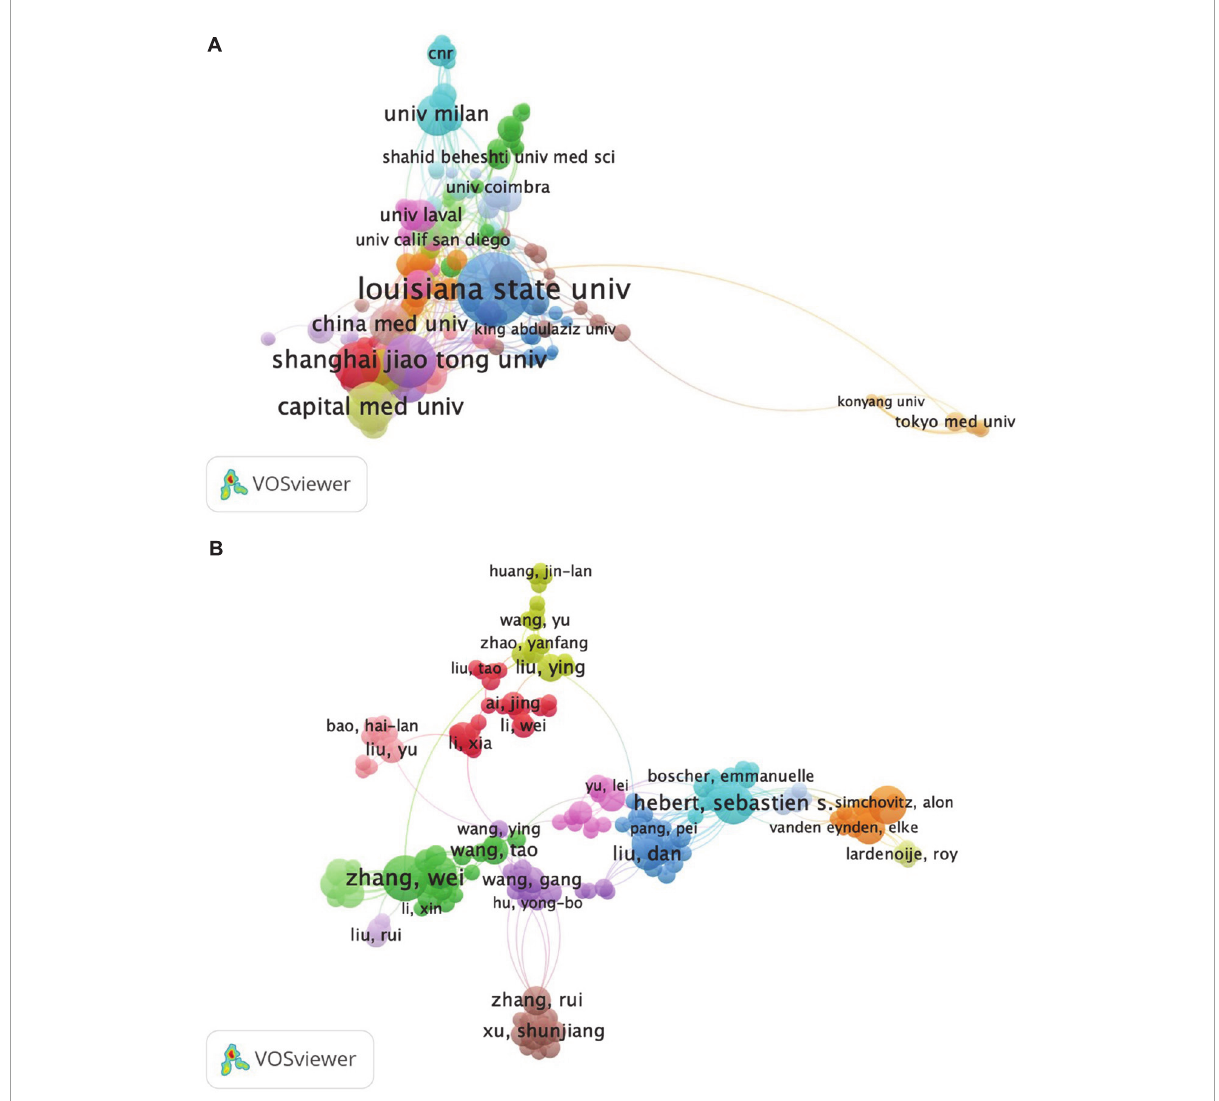
FIGURE4 The map of institutions’ cooperation (A) and authors’ cooperation (B) in the field of AD and ncRNAs in the past